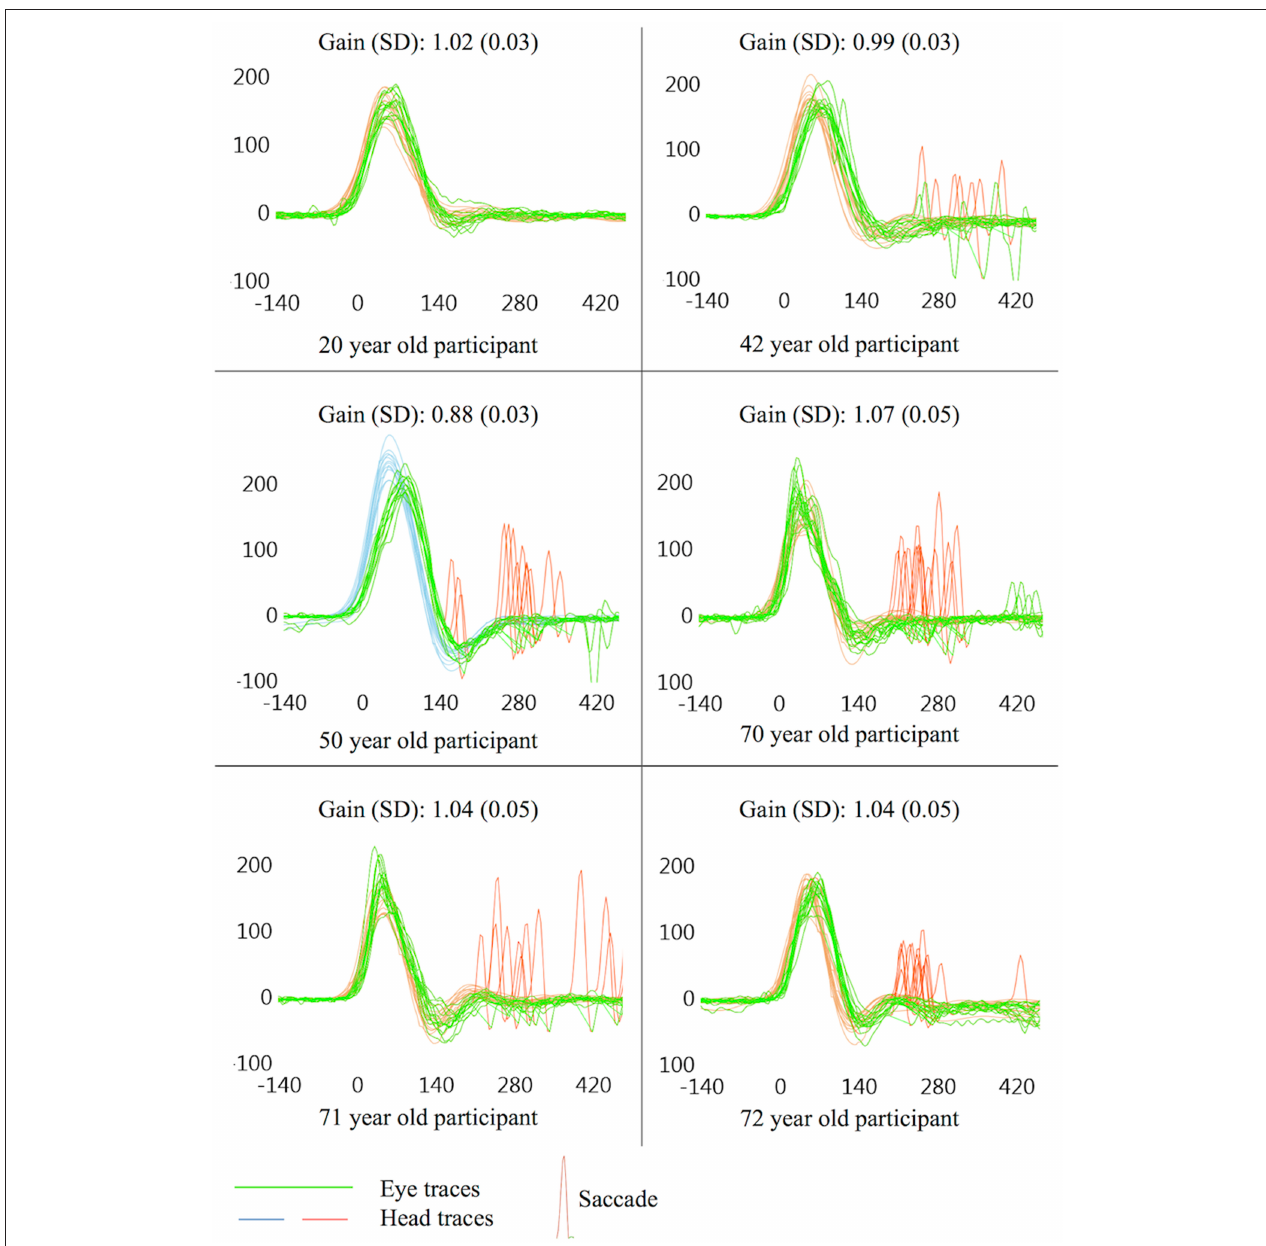
FIGURE 4 | Example vHIT traces. All examples taken from a single ear on the first trial (size 4), presented here to illustrate potential findings in symptomatically “normal” individuals. Non-pathological saccades are common in vHIT, especially in older individuals, and care should be taken during interpretation of vHIT saccade profiles so as to avoid false positive results, especially when non-pathological saccades are seen in traces that are also prone to sources of error which may lower